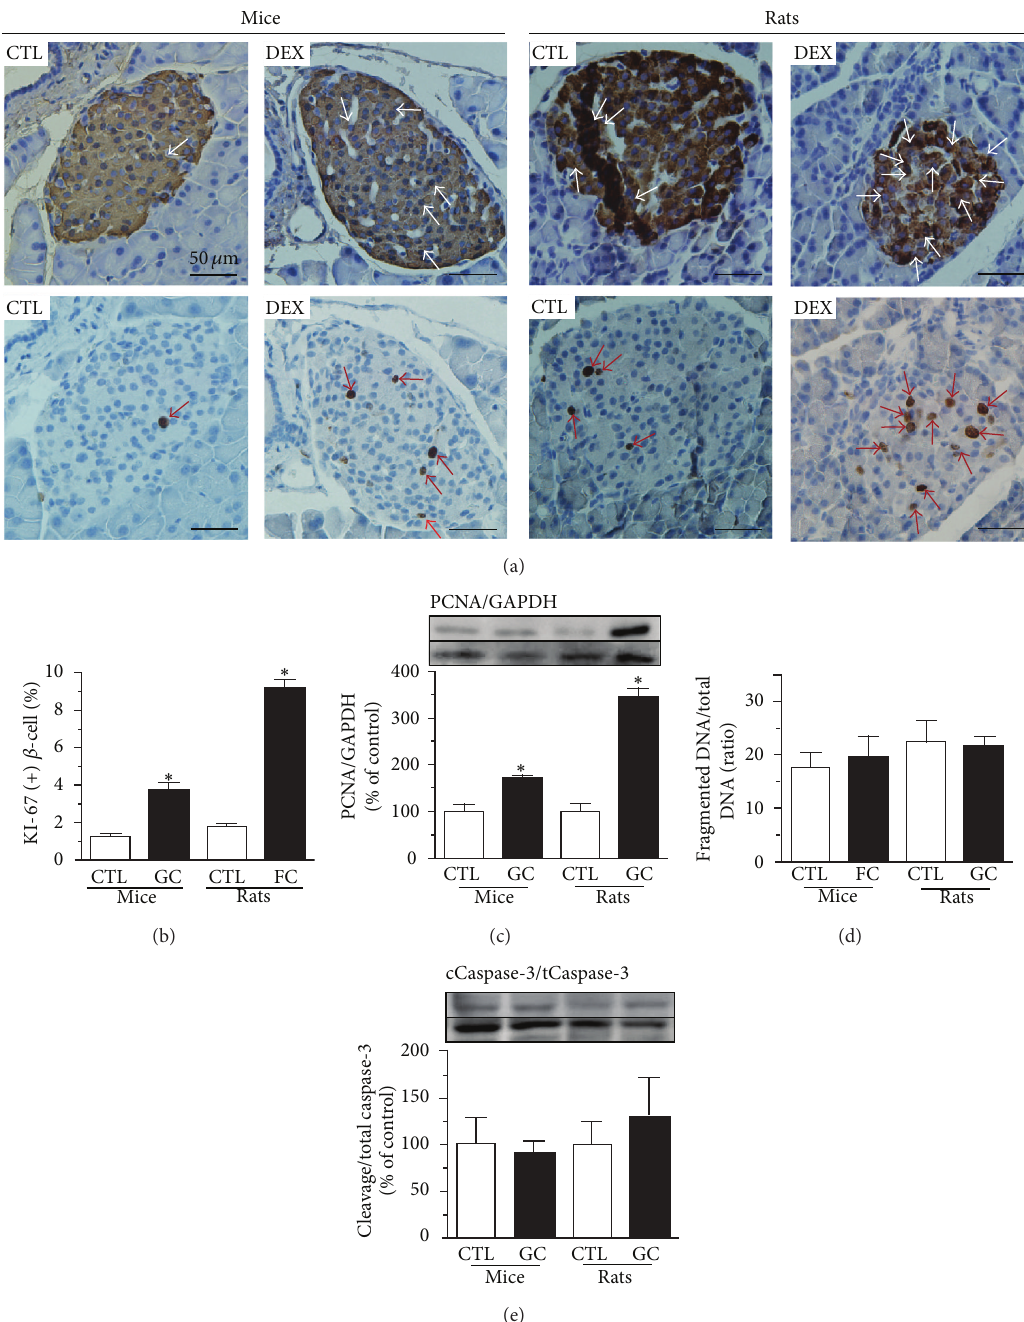
Figure 4: DEX treatment increases 𝛽 -cell proliferation without affecting apoptosis in the islets of mice and rats. (a) Representative pancreas sections stained for insulin (on the top) and KI-67 (at bottom), (b) percentage of KI-67-positive nuclei (+) 𝛽 -cell, (c) PCNA content, (d) DNA fragmentation/total DNA (ratio), and (e) caspase-3 cleavage/total caspase-3 ratio in islets from DEX-treated mice and rats. Values are mean ± S.E.M.; 𝑛 = 5-6 rodents per group; ≈ 100 islets per species ( ≈ 8500 nuclei per group). ∗ Significantly different compared to CTL. Unpaired Student’s 𝑡 -test, 𝑃 ≤ 0.05